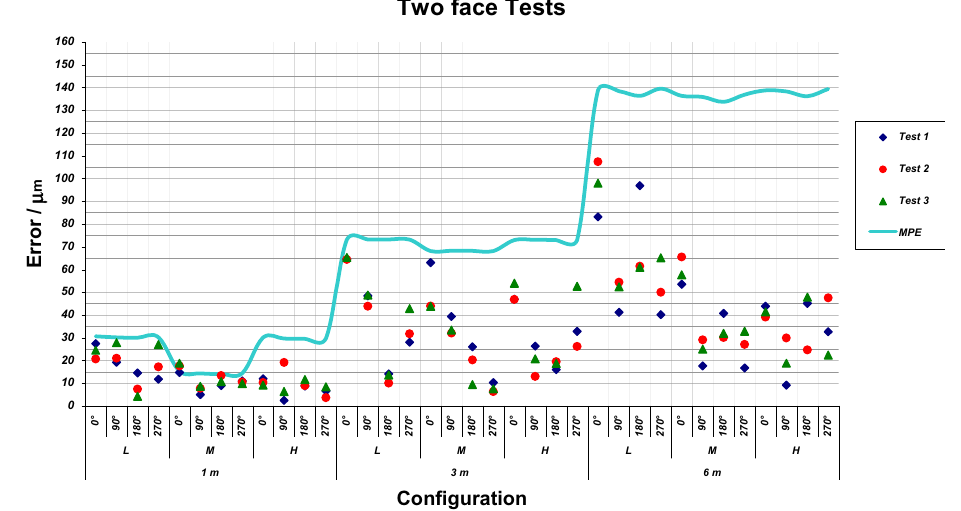
Fig. 10. Two face system test results